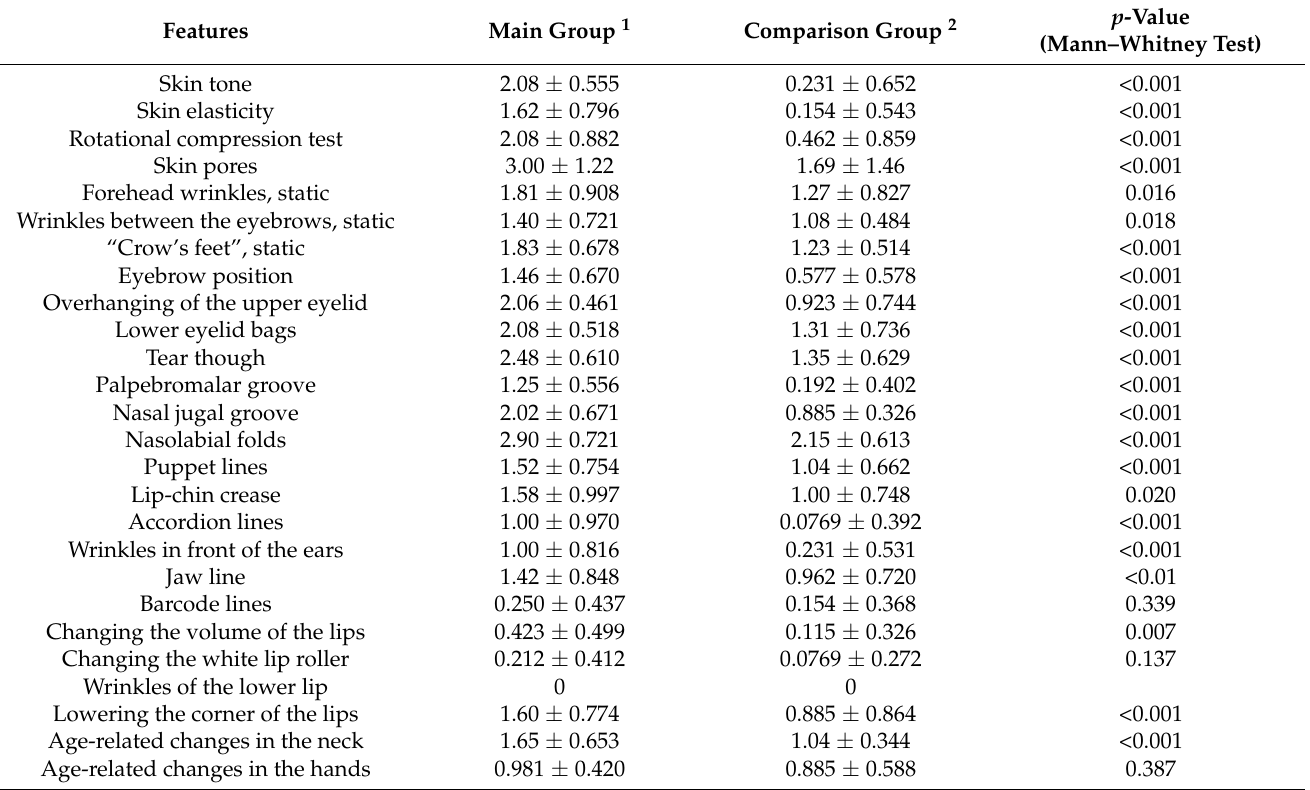
Table 2. Severity of age-related facial features; scores (M ±